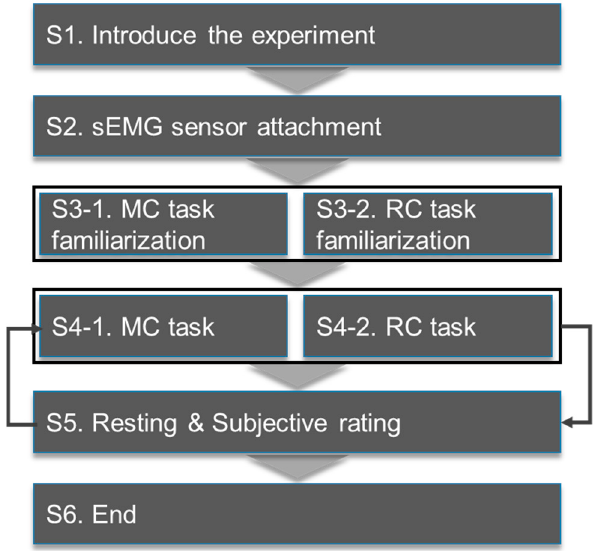
Figure 3. The experimental procedure.